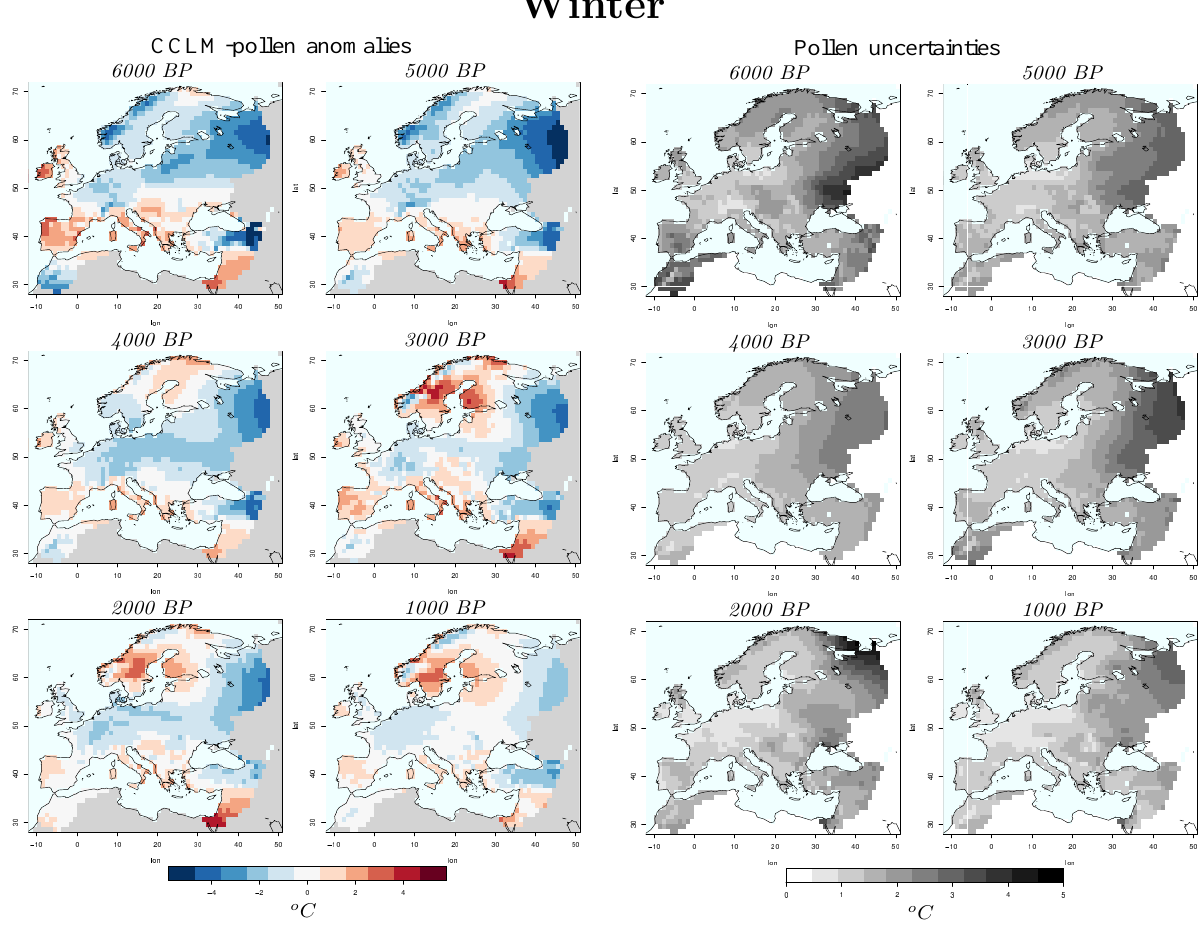
Figure 7. Left: maps of Winter 2m temperature anomalies between CCLM and pollen-based reconstructions for the different time slices of mid-to-late Holocene. Right: standard error of winter temperature seasonal mean derived from the pollen-based reconstructions for each time slice of mid-to-late